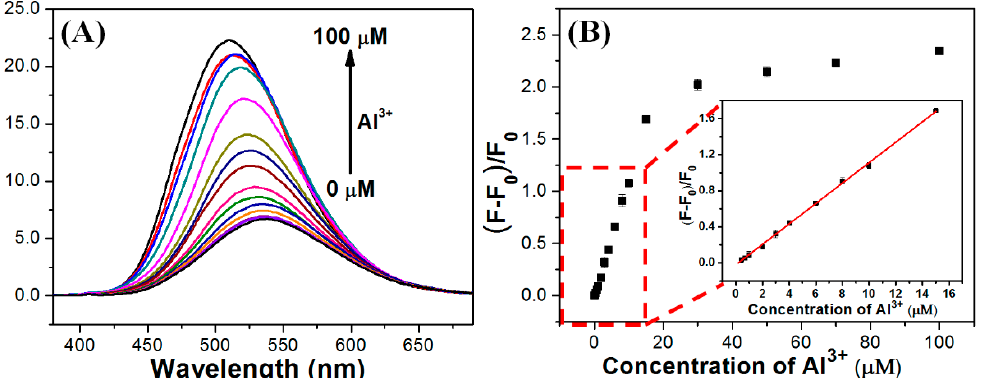
Figure 3. ( A ) Fluorescence response of Ti-MOF microflowers with various concentration of Al(III) (from bottom to top: 0, 0.4, 0.7, 1, 2, 3, 4, 6, 8, 10, 15, 30, 50, 70, 100 μ M). ( B ) Fluorescence enhancement rate ((F − F 0 )/F 0 at 510 nm) of Ti-MOF microflowers to Al(III) at various concentrations (0 to 100 μ M). The linear detection range for 0.4 − 15 μ M. Al(III) is shown in the inset image. The error bars represent standard deviations from three independent measurements.